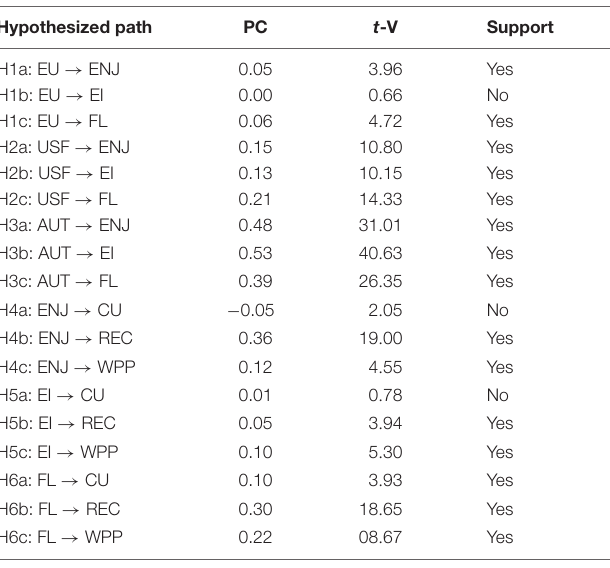
TABLE 5 | Hypotheses